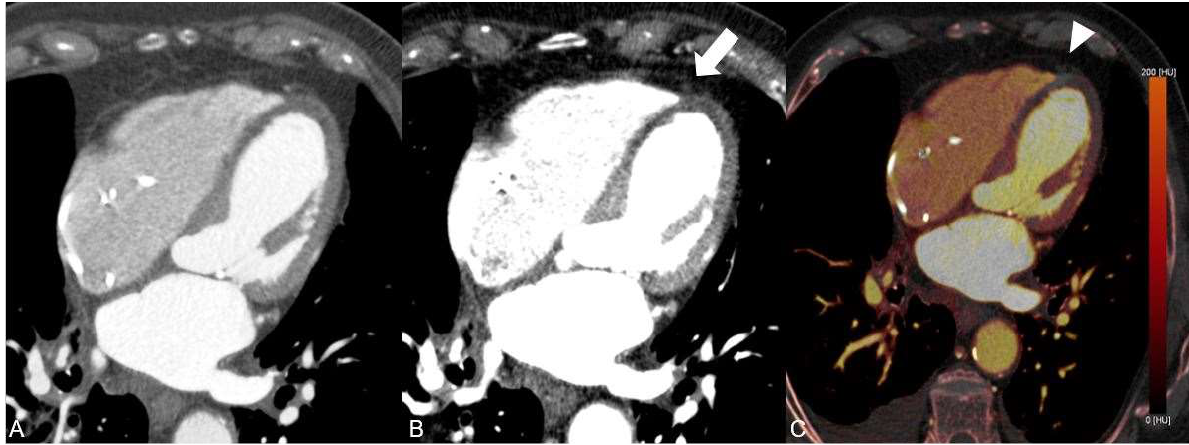
Figure 2. In comparison with the conventional arterial CT image ( A ), the complete lack of iodine in the distal course of the LAD can be visualized by application of dual-energy CT-based virtual mo- noenergetic images at 55 keV ( B , arrow) and corresponding iodine maps (C, arrowhead).